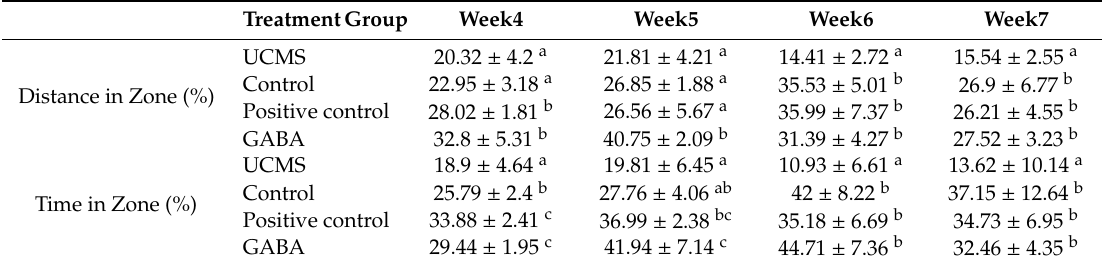
Data are represented as mean ± SD. Group with di ff erent letter superscripts are significantly di ff erent ( p <